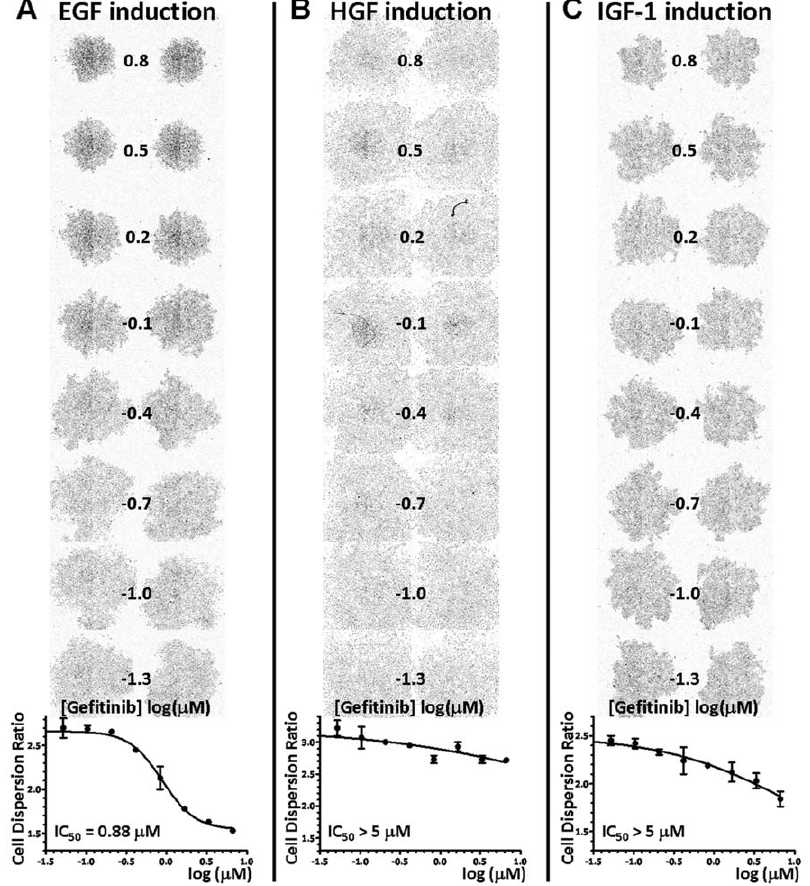
Figure 4. EMT inhibitory property of an EGFR inhibitor, Gefitinib. T2 plate image and CDR dose response profile of Gefitinib, against EGF- (A) HGF- (B) and IGF-1- (C) induced EMT.